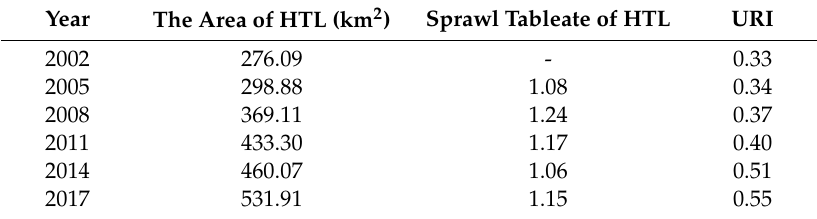
Table 7. The sprawl rate of hot thermal landscape (HTL) and urban heat island ratio index (URI) in Wuhan in 2002-2017.